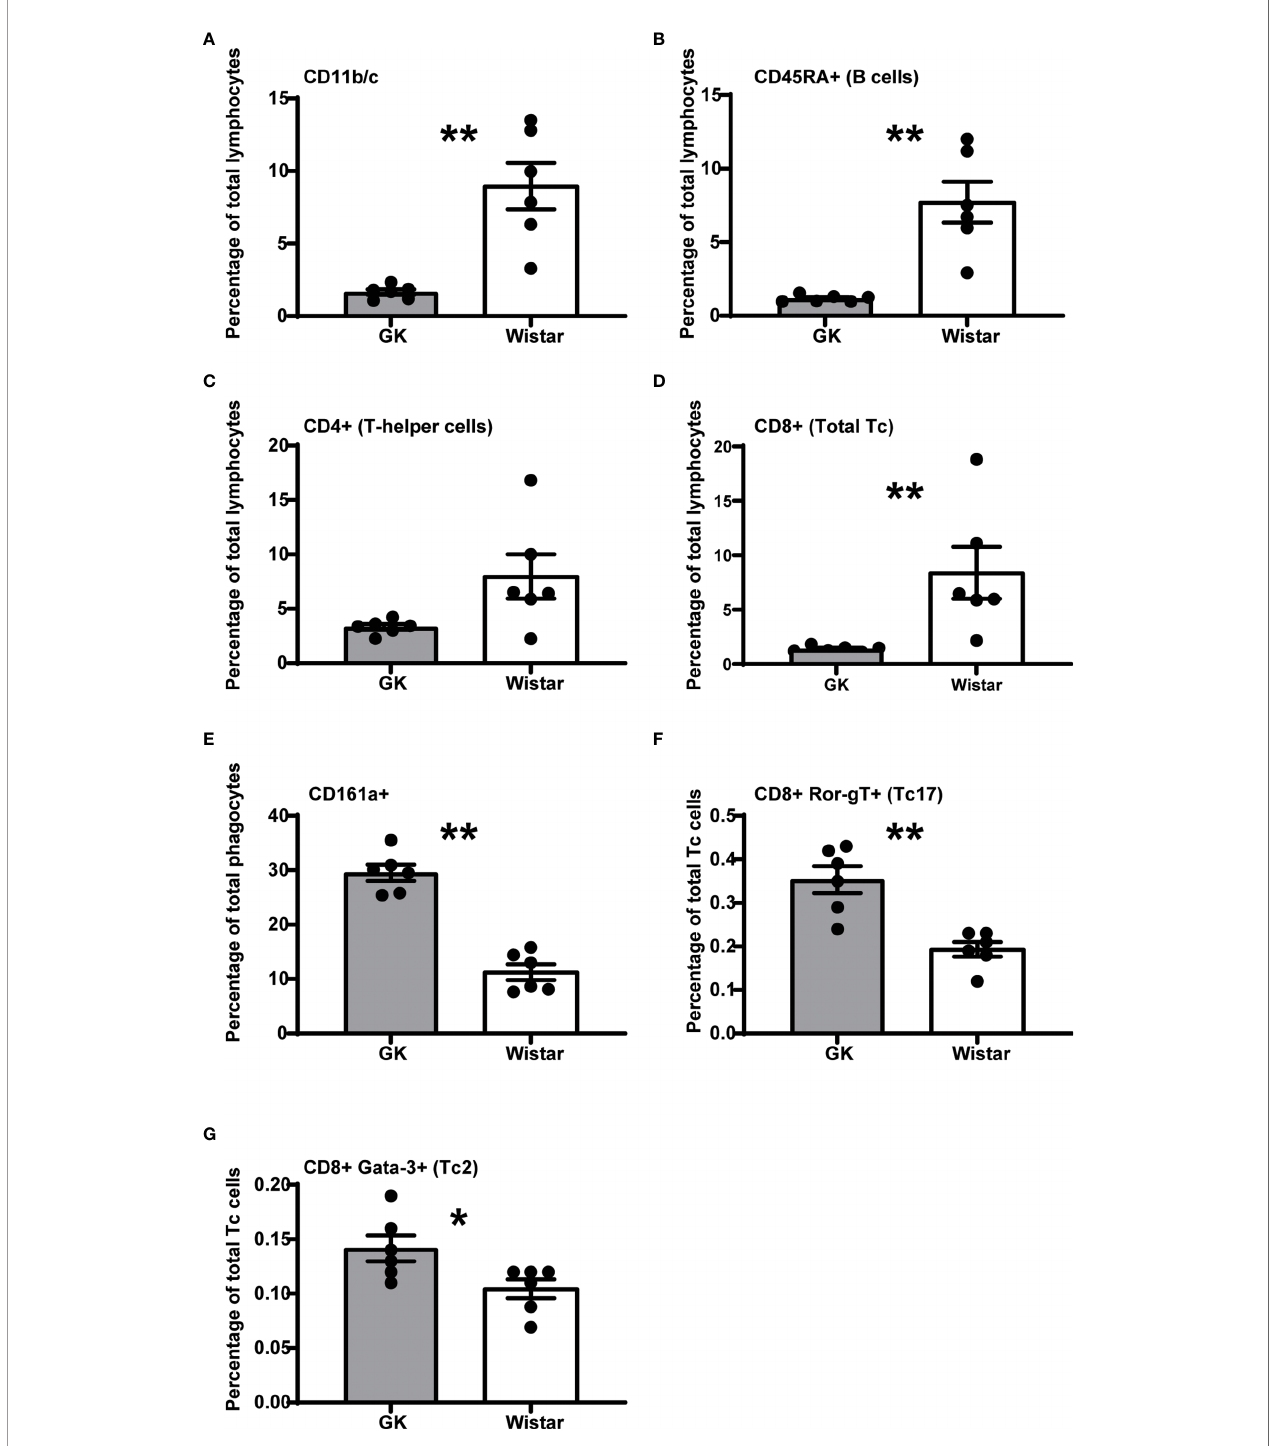
FIGURE 1 | The diabetic milieu majorly alters the GK immune system. Signi fi cantly affected immune cells (p<0.05), expressed as percentage of parent population frequency are, (A) CD11b/c+ phagocytes (macrophages, monocytes, dendritic cells, granulocytes), (B) CD45RA+ B cells, (C) CD4+ T-helper cells, (D) CD8+ T- cytotoxic cells (E) CD161a+ NK cells, T-cell subsets, activated monocytes, and dendritic cells (F) CD8+ ROR g T+ T c 17 cells (G) GATA3+ T c 2 cells. However, the T- helper cells narrowly missed the signi fi cance threshold (p = 0.0649). Data are mean +/- SEM; individual animals shown as dots. Grey bars: GK rats (n = 6); white bars, Wistar rats. (n =